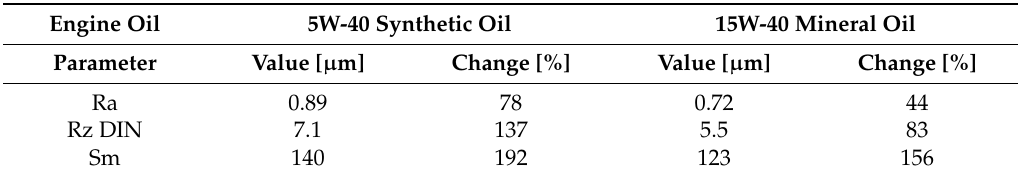
Table 5. Roughness of counterparts from SAE-48 after the test under pressure 20 MPa (DIN 4768, ISO